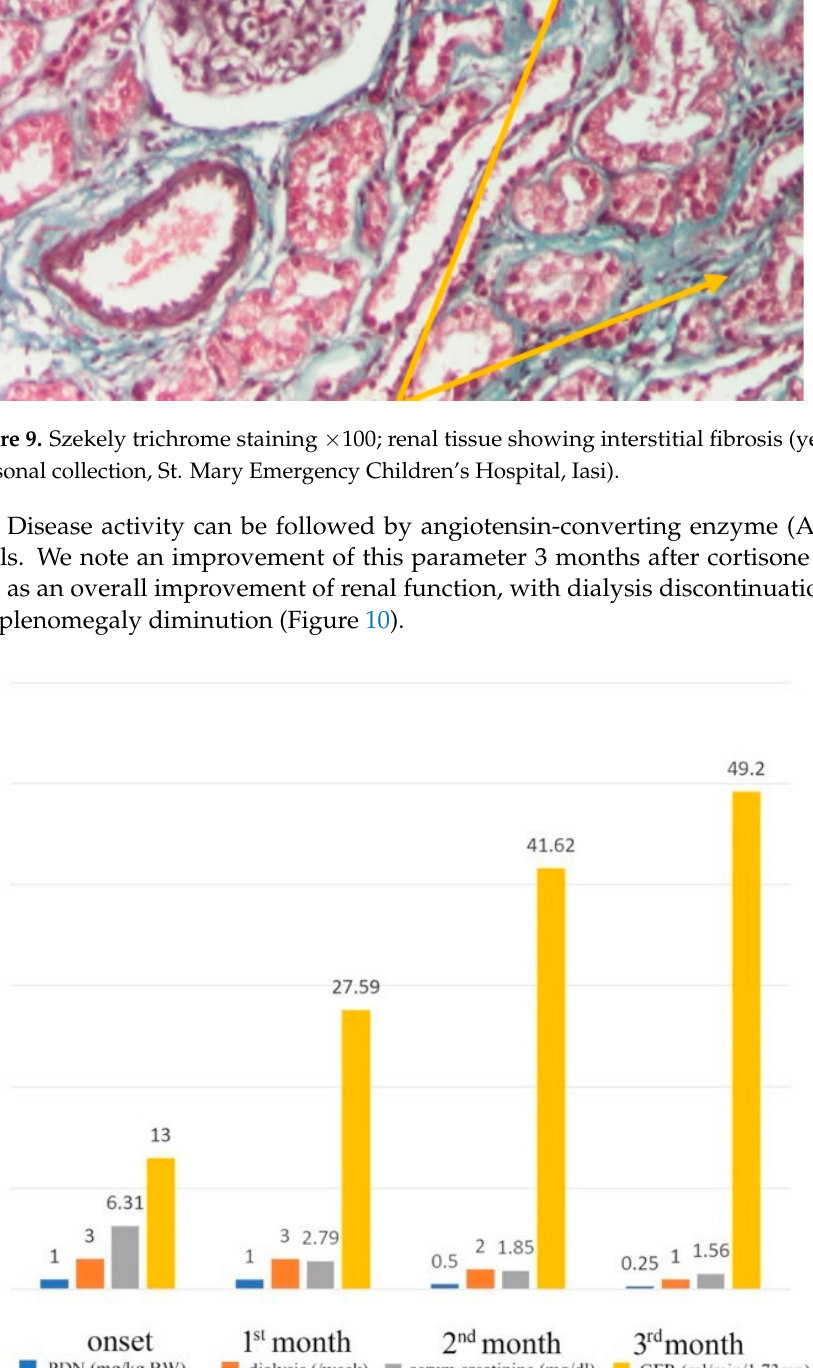
Figure 10. Characteristics of our patient at presentation, 1, 2 and 3 months after therapy initiation. Our evaluation concluded with the diagnosis of extrapulmonary pediatric-onset adult-type sarcoidosis with nephrocalcinosis, nephrolithiasis, non-granulomatous nephri- tis, granulomatous hepatitis, portal hypertension, hepatic insu ffi ciency, splenic infarc- tions, and band keratopathy. 3. Discussions Sarcoidosis is a disease characterized by the formation of nodules of in fl ammatory cells or noncaseating granulomas in any part of the body—most commonly in the lungs and lymph nodes. However, it can also a ff ect the eyes, skin, heart, kidneys, central nerv- ous system, or sense organs. Sarcoidosis, or Besnier-Boeck-Schaumann disease, was fi rst identi fi ed by the English doctor Johnathan Hutchinson in 1877, and although more than a hundred years have passed since that fi rst description, the disease still remains an enigma [6]. The incidence of sarcoidosis in adults appears to be biphasic [3]. Historically, it was thought to a ff ect young adults between 30 and 50 years, but recent studies have reported that more than half of cases are patients over 55 years of age [3,7]. About 25% of